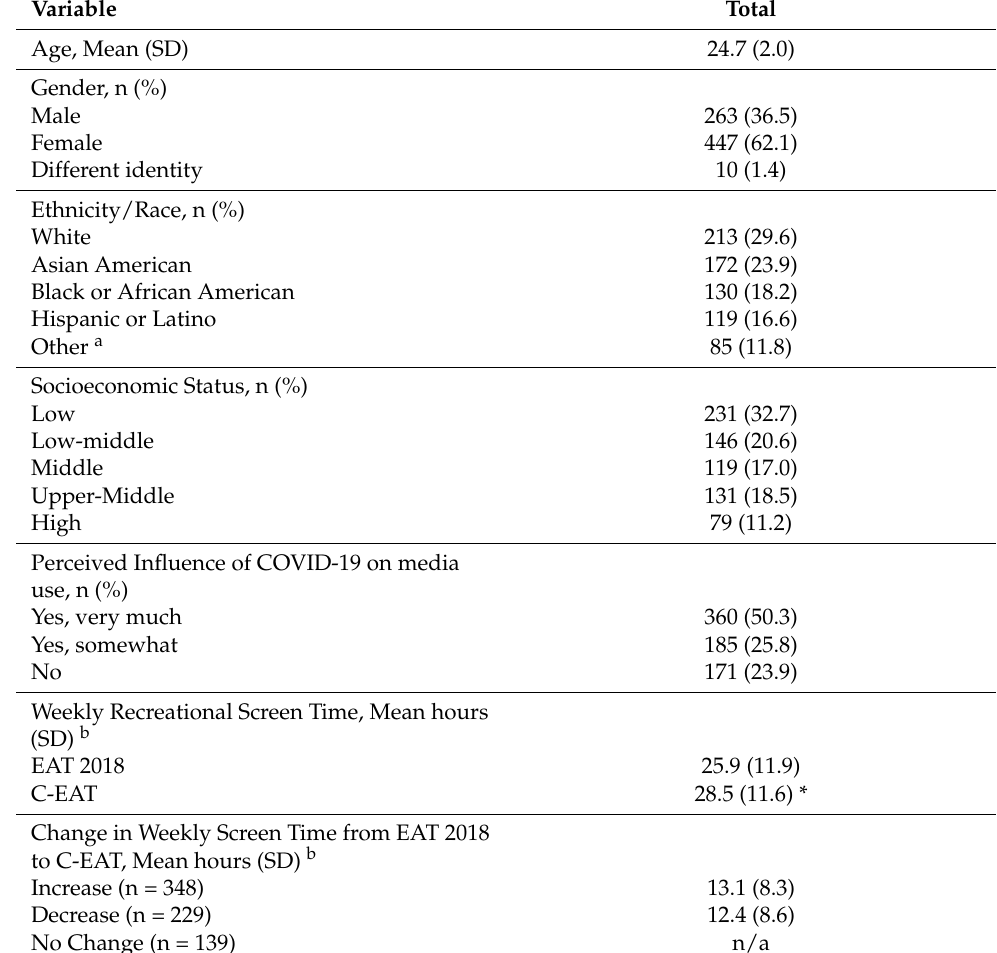
Table 1. Participant demographics and screen time behaviors (n =